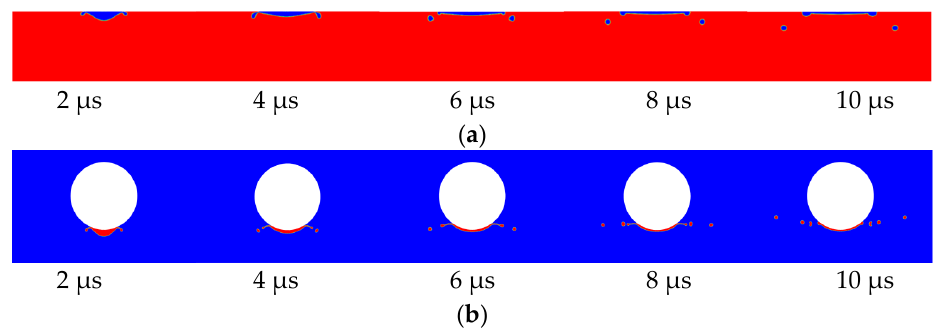
Figure 6. Dynamic evolution diagram of droplet impact process: ( a ) droplet impacting flat wire; ( b ) droplet impacting circular wire.